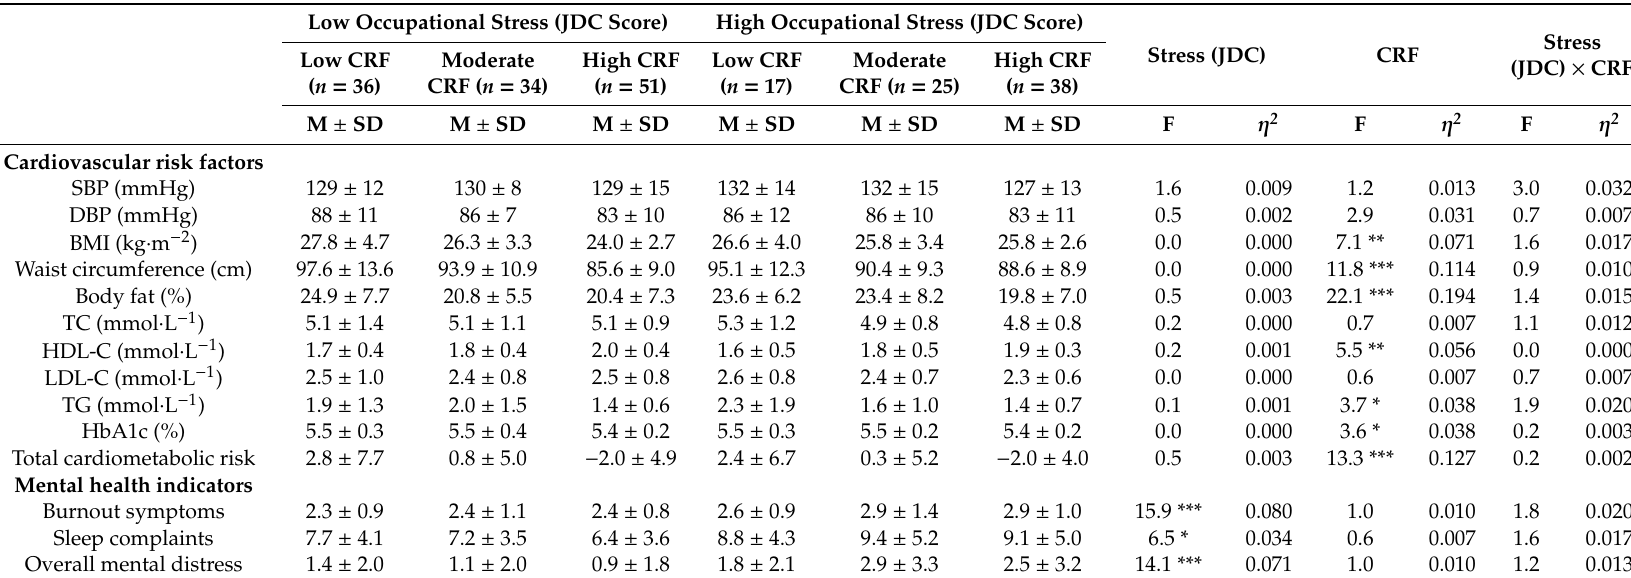
Table 2. Di ff erences in cardiometabolic risk factors, and mental health indicators, dependent on participants’ levels of CRF and perceived occupational stress (as assessed via the job demand and control [JDC]